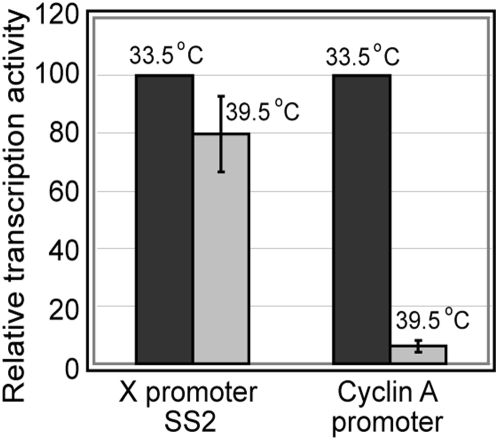
TAF1 is marginally important for X gene transcription in ts13 cells.ts13 cells were transfected with a firefly luciferase reporter plasmid driven by the X gene core promoter 2 or the cyclin A promoter. After 16 hr of incubation at the permissive (33.5°C) or nonpermissive (39.5°C) temperature, the luciferase activity in transfected cells were measured and normalized for transfection efficiency. Brackets show standard error of means.